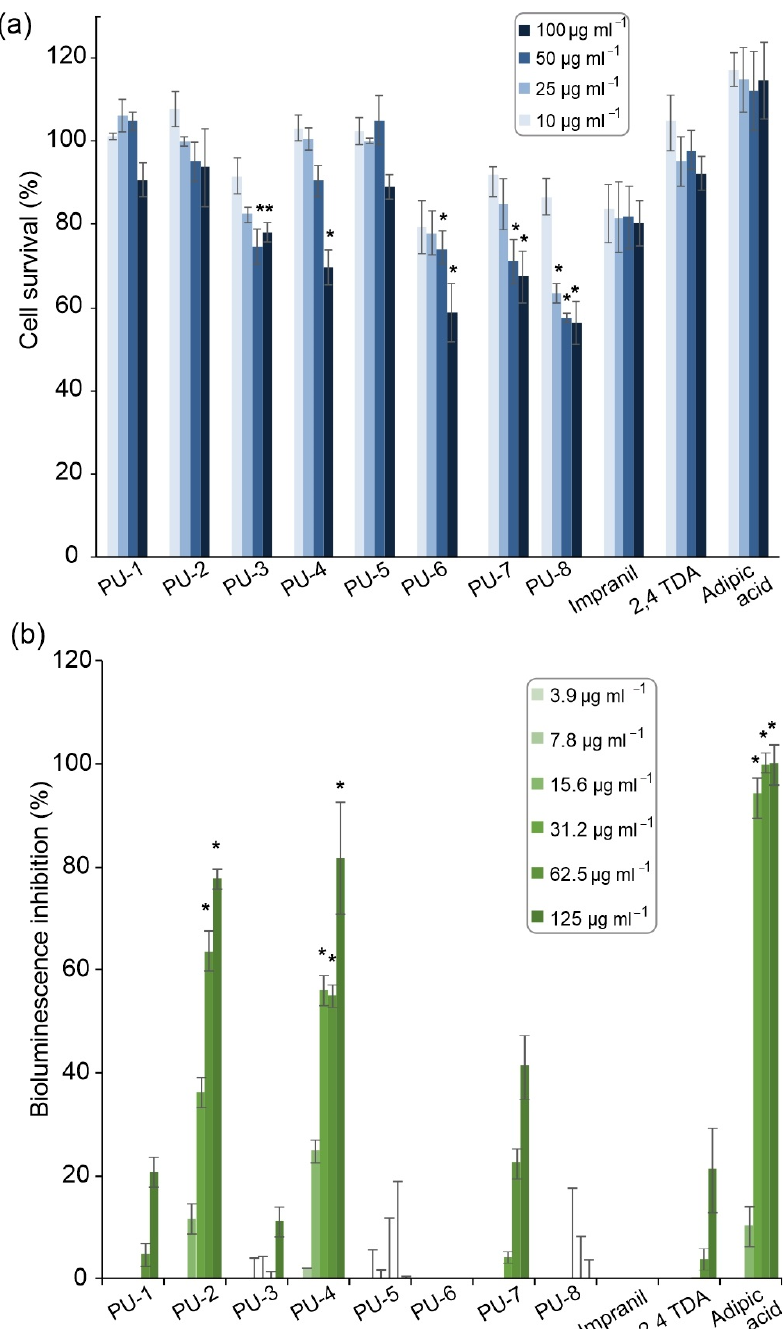
Figure 2. Quantification of in vitro MRC ‐ 5 cells survival in the presence of PU model compounds at concentration range ( a ). Inhibitory effect of PU model substrates on A. fischeri bioluminescence at concentration range ( b ). The effect was compared to untreated control using a t -test, * p ≤ 0.01.